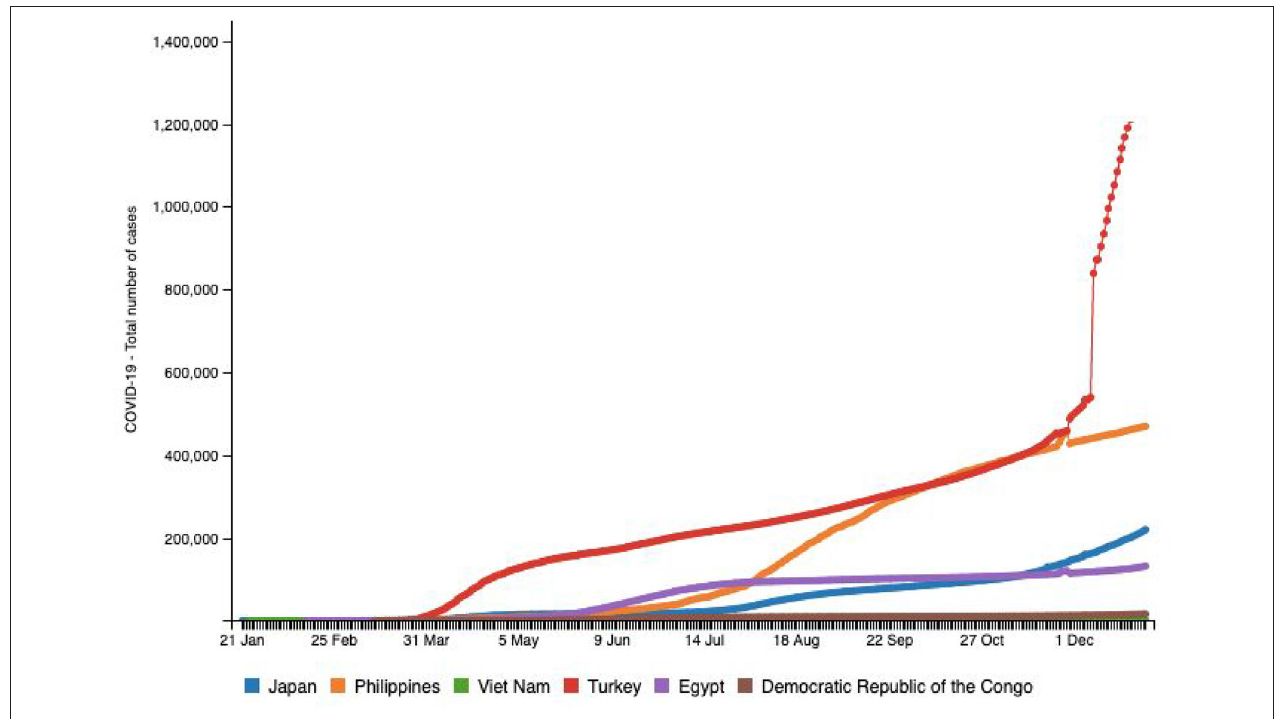
FIGURE 6 | Source: http://www.smaartrapidtracker.org, accessed on December 29, 2020. Total number of cumulative cases of COVID-19 in the world, Vietnam, Japan, Philippines, Turkey Egypt, and Congo (January 21, 2020 to December 29,